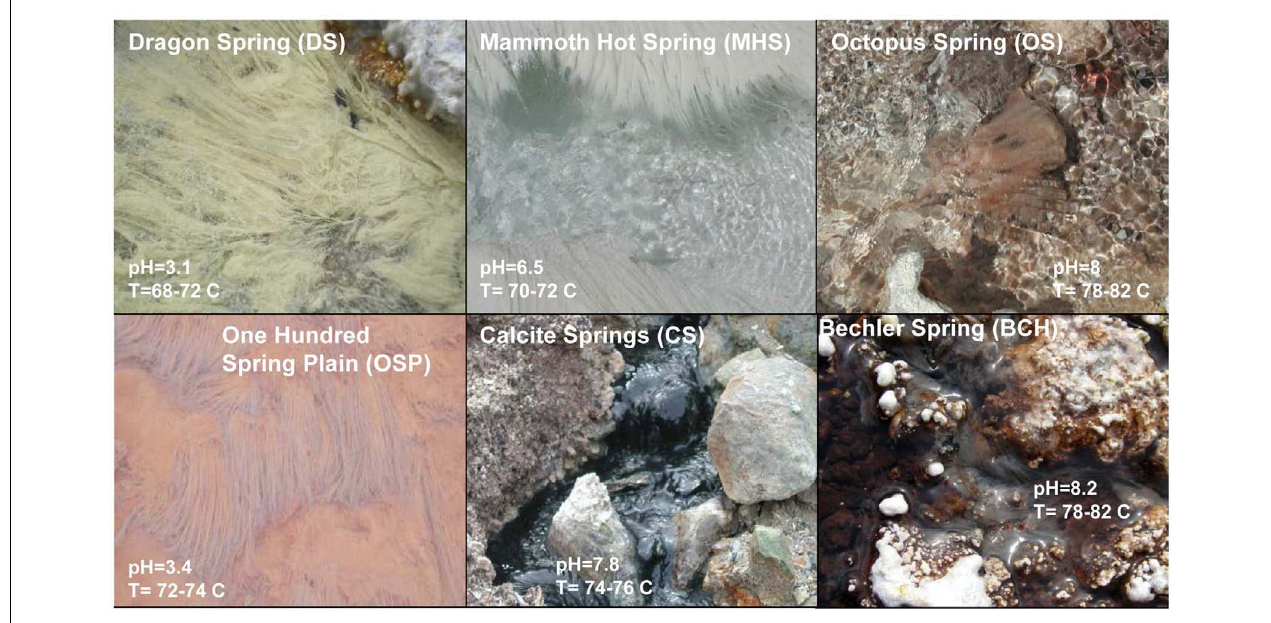
visually [DS_9 (elemental sulfur); OSP_14 (Fe-oxides); MHS_10 (calcium carbonate); CS_12 (pyrite, amorphous Fe-sulfides); OS_11 (none); BCH_13 (none, Fe(III)-staining on